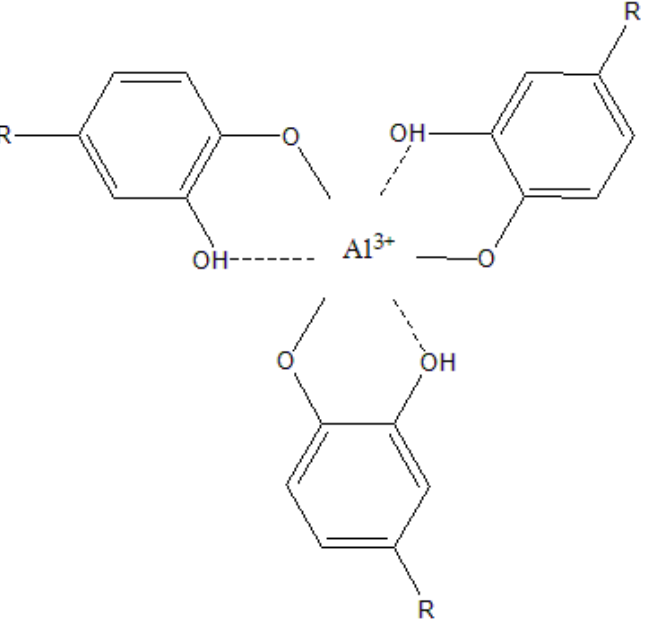
Figure 7. Chemical structure of Al(III) complex with caffeic acid as a ligand, R: CH=CHCOOH or CH=CHCOO − .